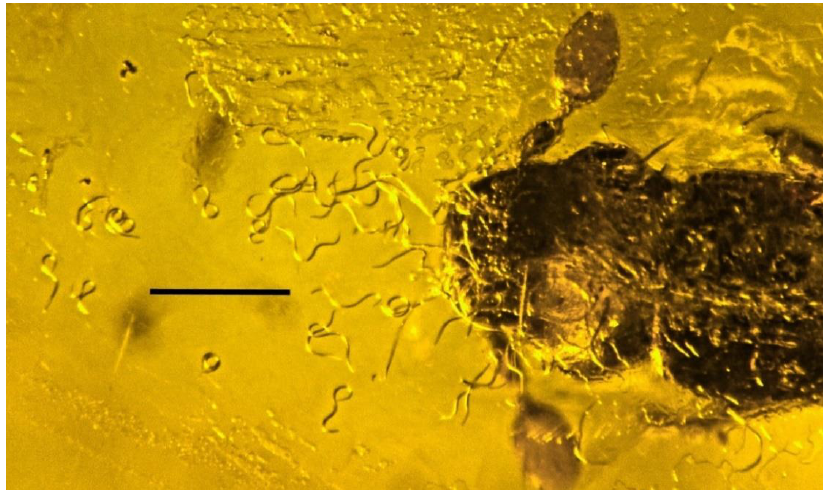
Figure 30. Dauer stages of the fungivorous aphelenchoidid nematode, Cryptaphelencus dominicus (Nematoda: Aphelenchoidea) that were phoretic on a platypodine (Coleoptera: Curculionidae) beetle in Dominican amber. Scale bar = 460 µm.